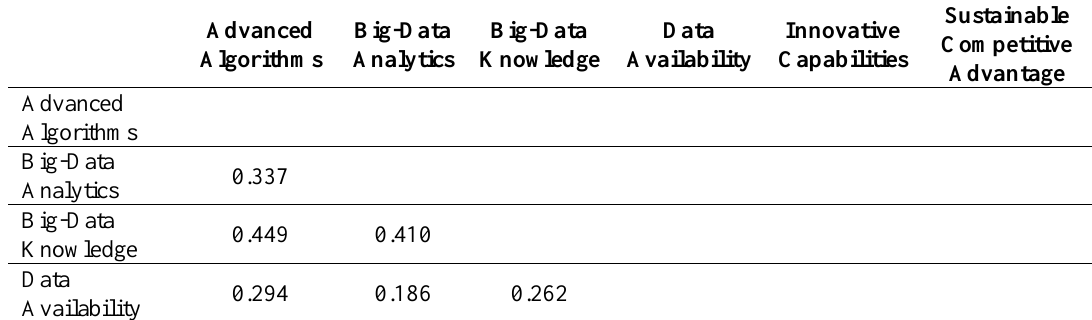
Table.4. Heterotrait-Monotrait Ratio (HTMT) & Discriminant Validity